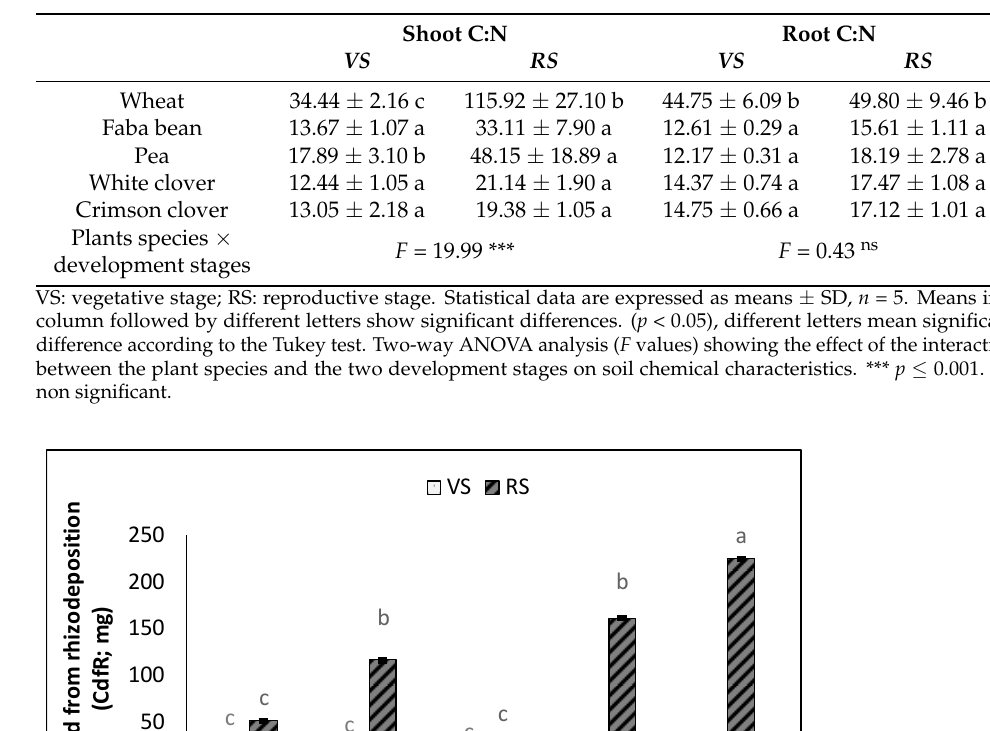
Table 3. Shoot and root C:N ratios for all studied plants species.